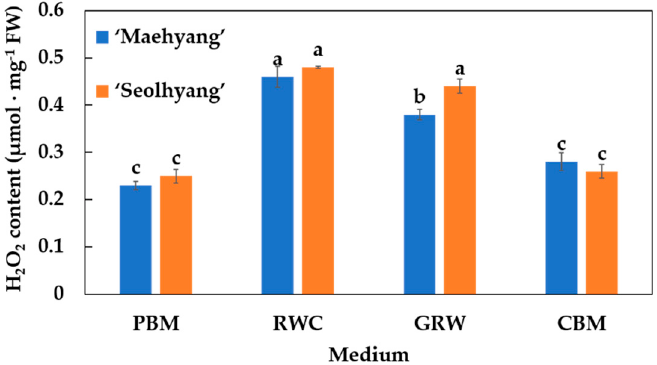
Figure 7. The e ff ects of growth medium on the hydrogen peroxide (H 2 O 2 ) content of two cultivars of strawberry ‘Maehyang’ and ‘Seolhyang’ daughter plants grown with a 12-day fogging. The error bars represent the SEs of biological replicates ( n = 3). According to Tukey’s test, lowercase letters at p ≤ 0.05 indicate significant di ff erences between di ff erent treatments .